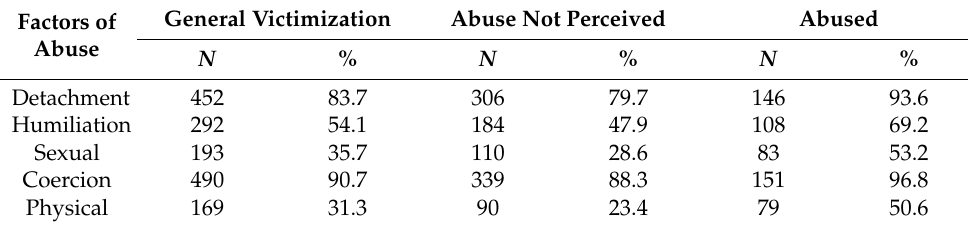
Table 4. Factors of victimization suffered by young people between 15 to 27 years old. Factors